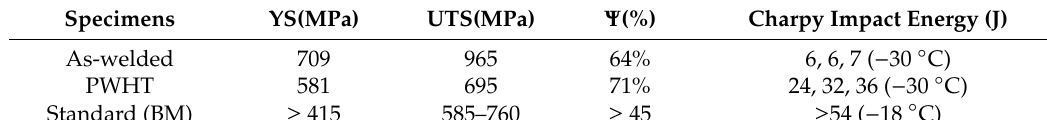
Figure 4. Microstructure of the weld metal for ( a ) as-welded and ( b ) post-weld heat treatment (PWHT)